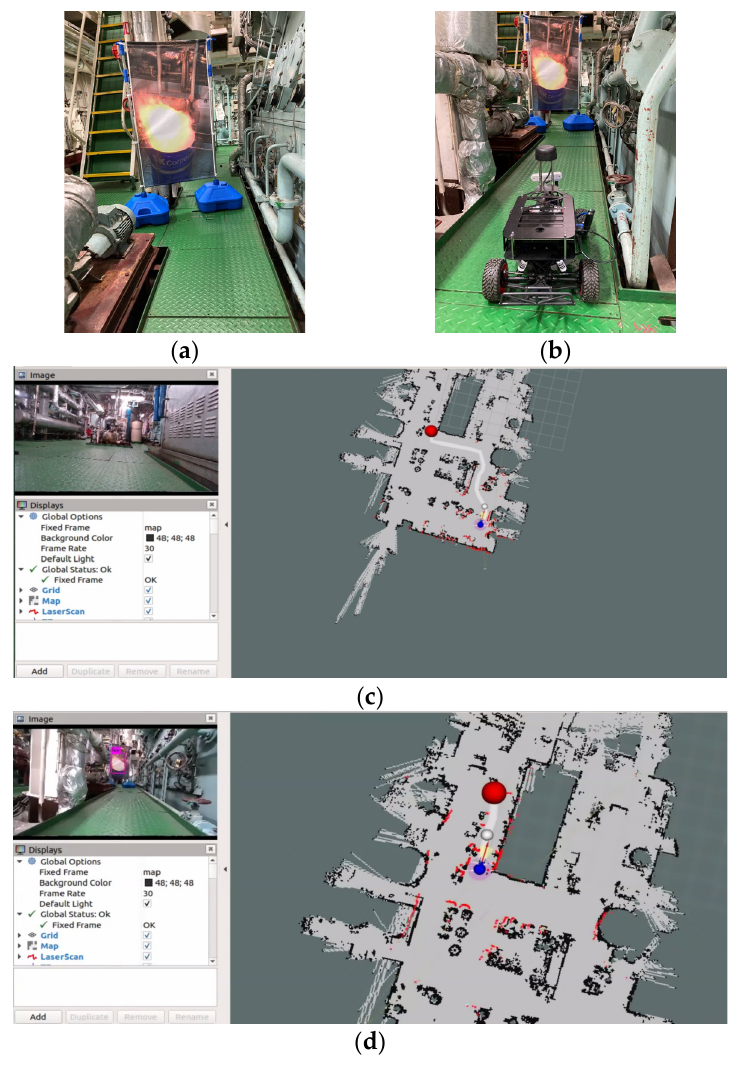
Figure 9. Engine room surveillance experiment result. ( a ) virtual fire banner installation ( b ) Image of a robot arriving at a virtual fire. ( c ) Set initial destination. ( d ) Set new destinations and moving autonomously. Red dot is destination, blue dot is current location of autonomous mobile robot.